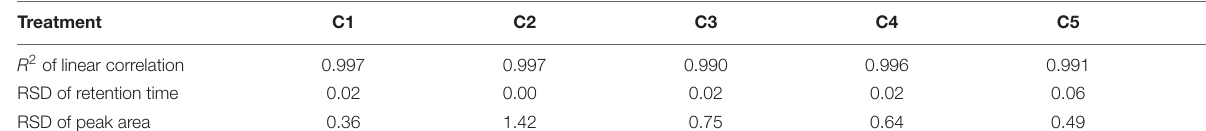
TABLE 3 | Analysis of variances of characteristic peak.